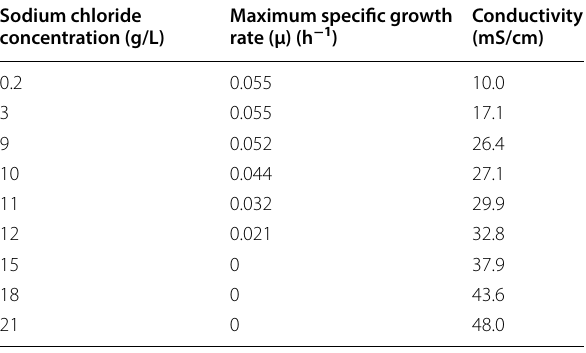
Table 1 Maximum specific growth rates for each sodium chloride concentration, expressed in h − 1 and sodium chloride concentration represented as conductivity in mS/ cm Sodium chloride Maximum specific growth Conductivity concentration (g/L) rate (µ) (h − 1 )